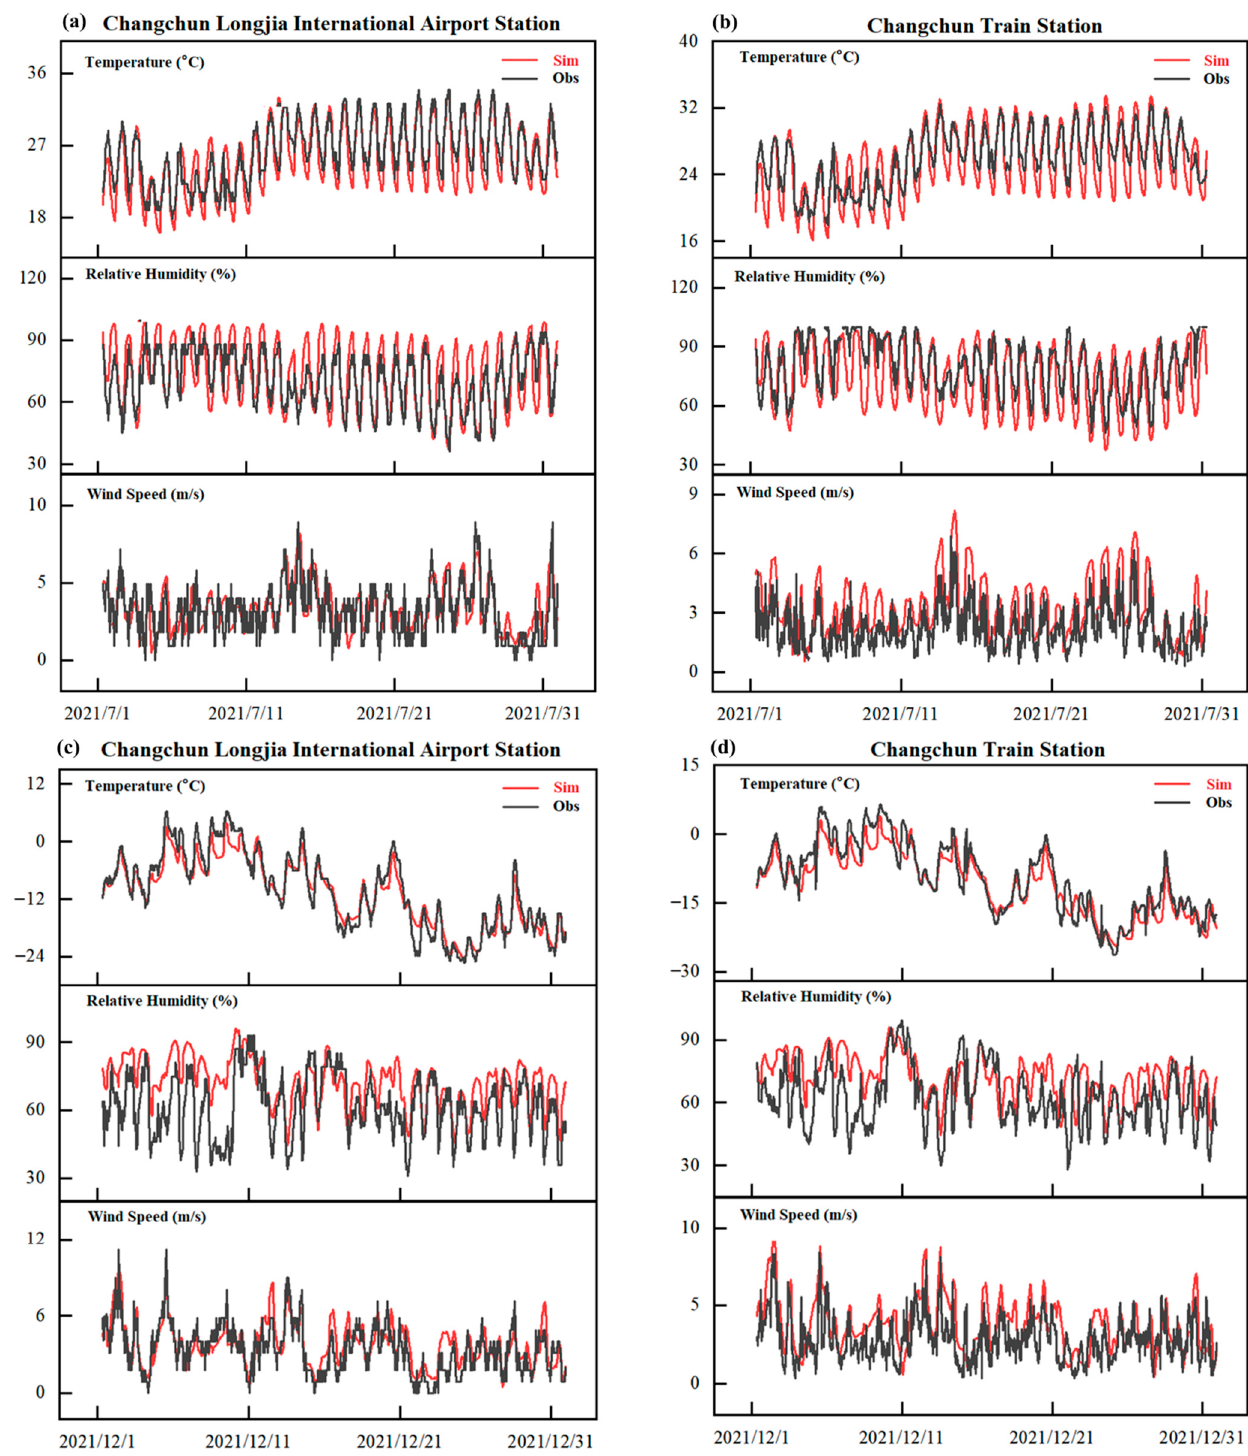
Figure 2. Time series of simulated and observed hourly air temperature at 2 m, relative humidity and wind speed at the two monitoring sites of Changchun for July and December 2021.